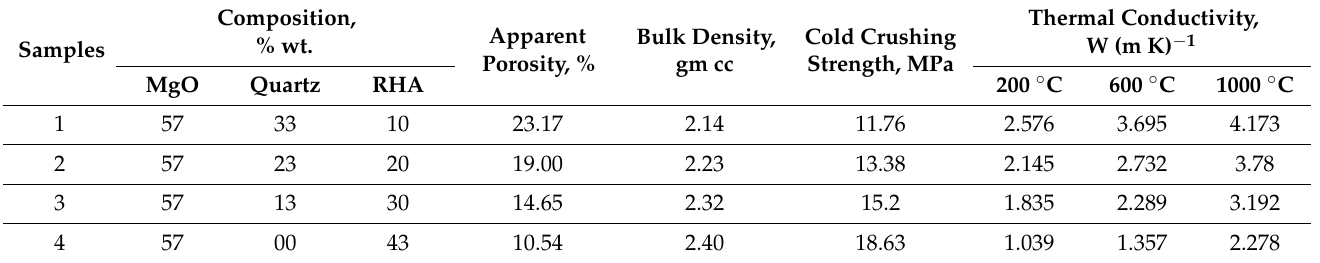
Table 14. Composition and properties of forsterite ceramics produced using rice husk ash. Data from [53]. Composition, % Samples